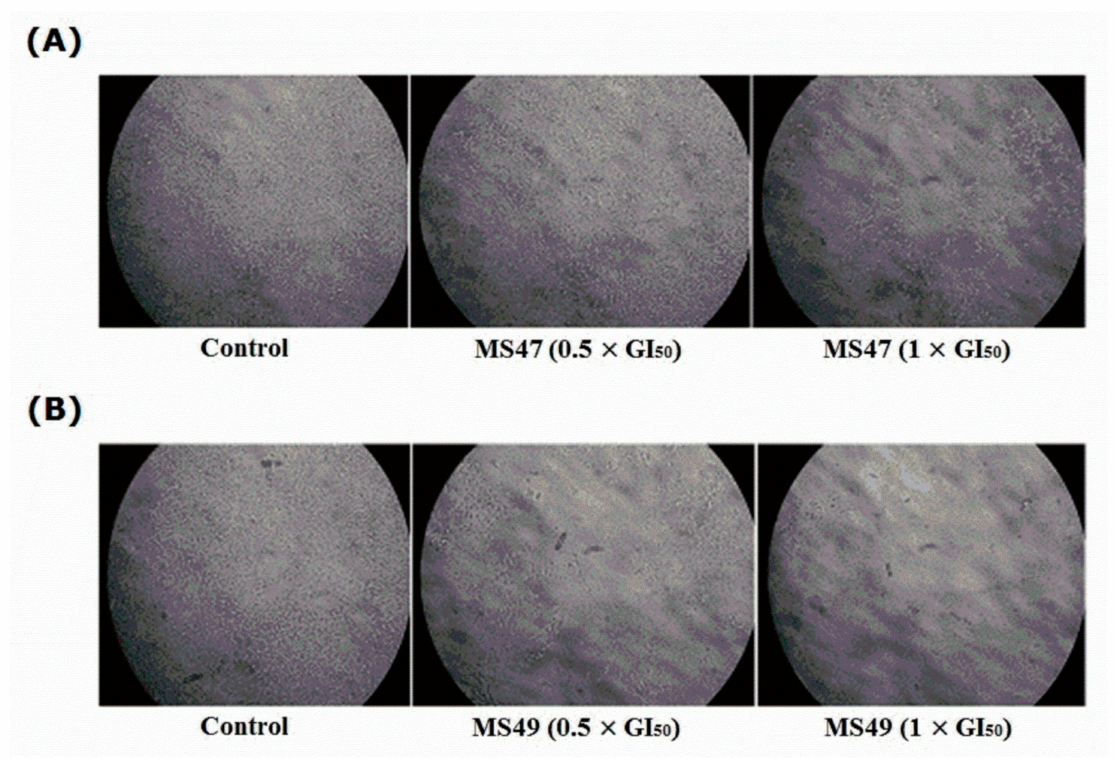
Figure 9. Human melanoma MDA-MB435 cells; untreated (control) and treated with (0.5 × GI 50 and 1 × GI 50 ) of ( A ) ligand MS47 and ( B ) ligand MS49 for 72 h after incubation with β -galactosidase (SA) staining solution at 37 ◦ C overnight (12–16 h) in a dry incubator (without CO 2 ). Treated cells did not show any blue color, as both ligands did not induce